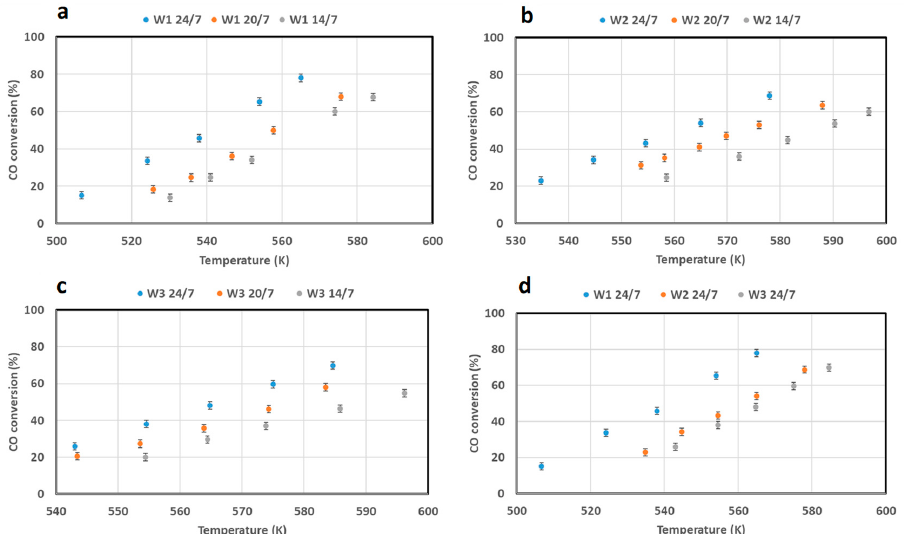
Figure 5. CO conversion as function of temperature for di ff erent H 2 O / CO ratio (24 / 7, 20 / 7, 14 / 7) for each powder catalyst: W1 ( a ), W2 ( b ) and W3 ( c ), and CO conversion comparison as function of the temperature at the same H 2 O / CO ratio (24 / 7) for the three catalysts ( d ). τ = 131